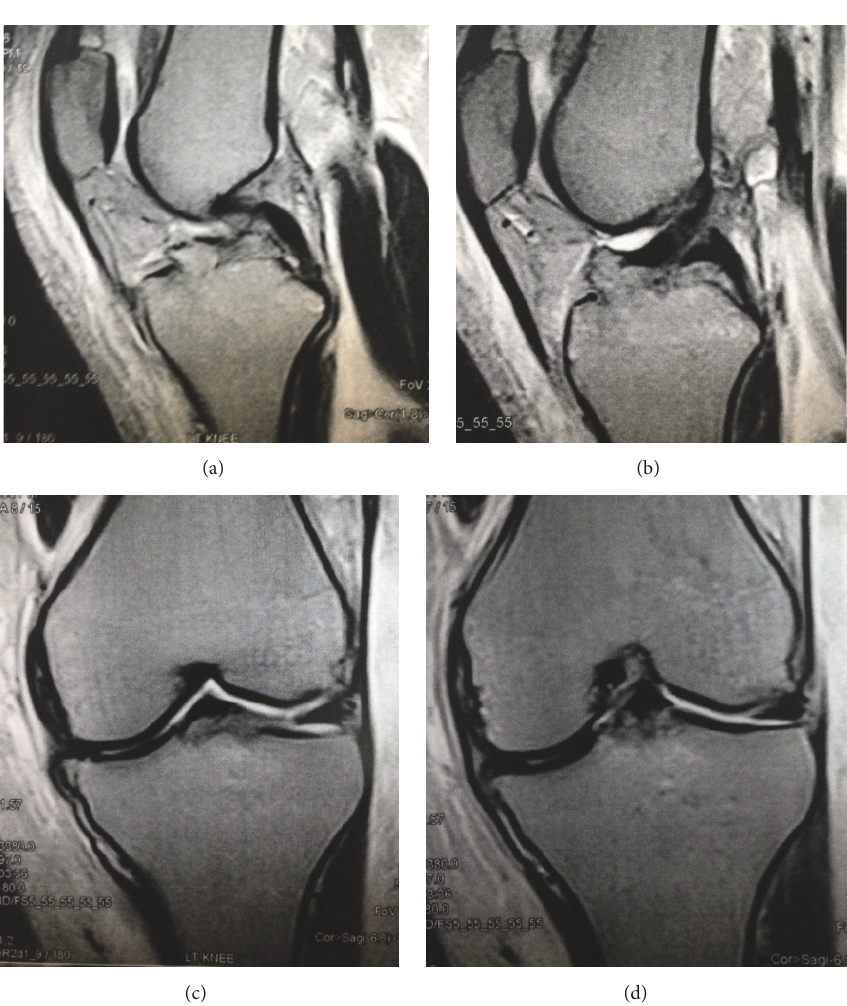
Figure 3: Magnetic resonance imaging showing intact PCL (a), avulsion of the tibial attachment of the ACL (b), reverse Segond fracture (c), and intact superficial MCL (d).